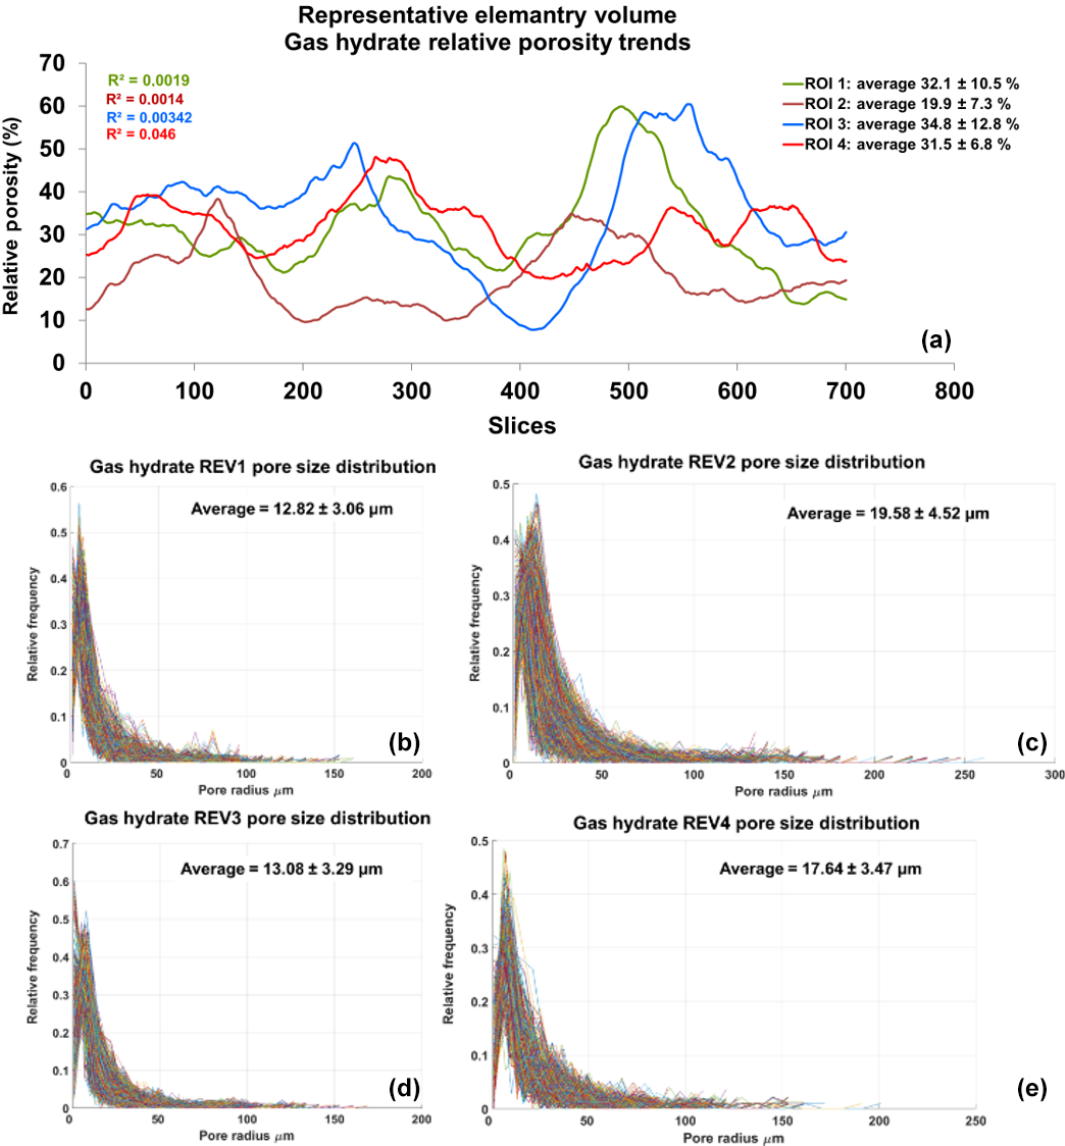
Figure 7. Panel (a) shows relative porosity trend analysis of gas hydrates; panels (b–e) show the geometrical pore size distribution of the respective REVs. The analysis was performed using CobWeb